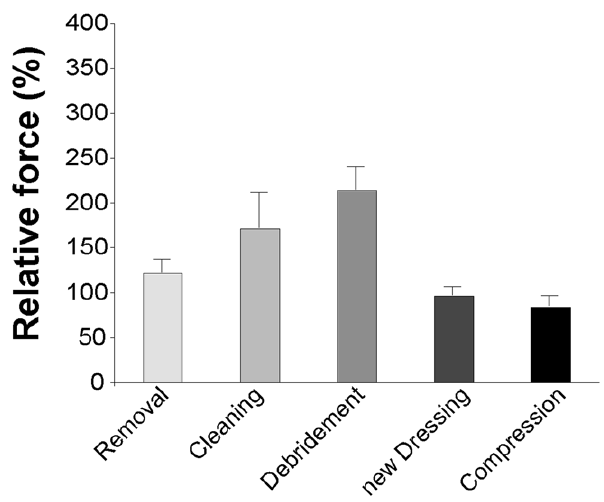
Figure 4. Patients’ standardized mean PM ratings of the five different dressing change steps. Bars depict average values and their S.E.